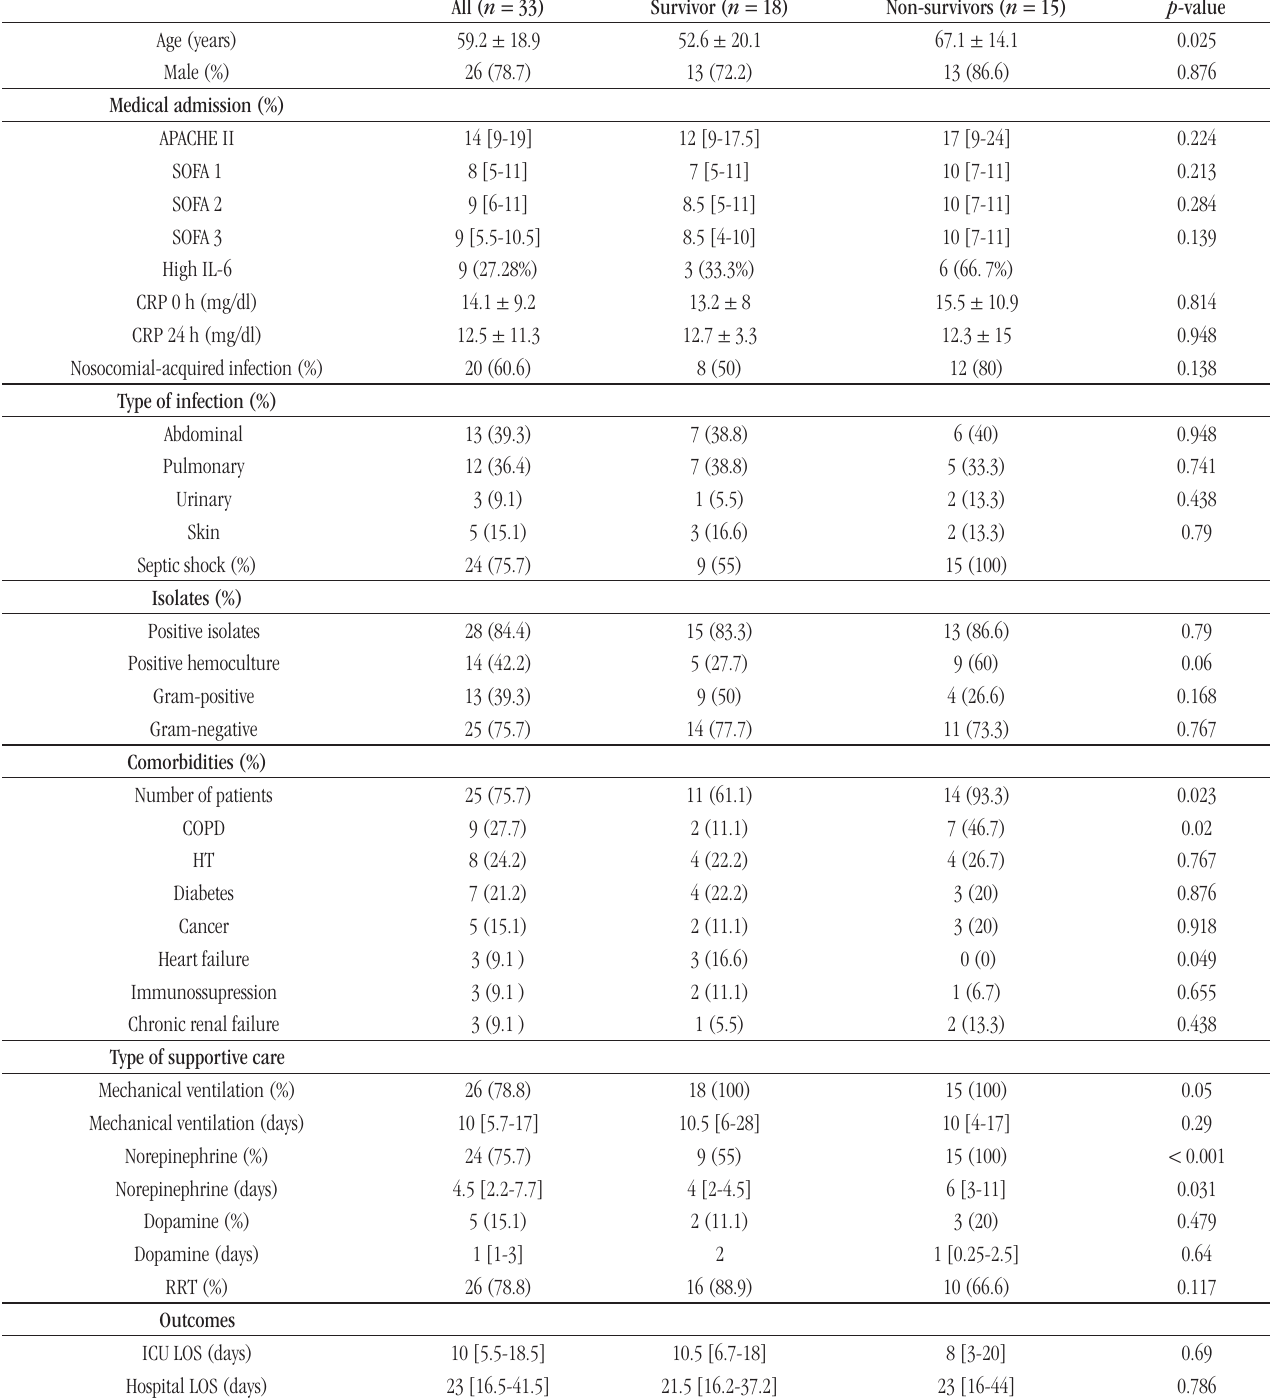
taBLE 1 − Characteristics of the